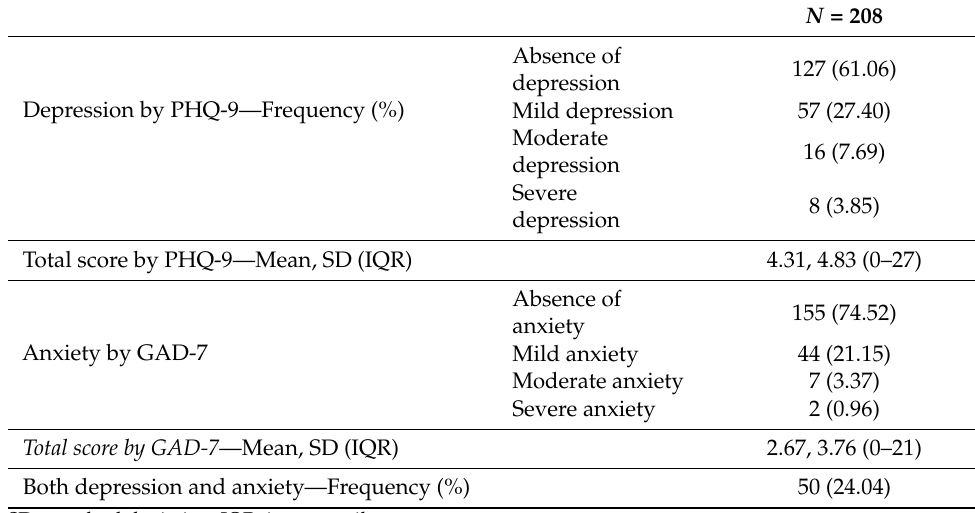
Table 3. Prevalence of depression and anxiety among hospital health